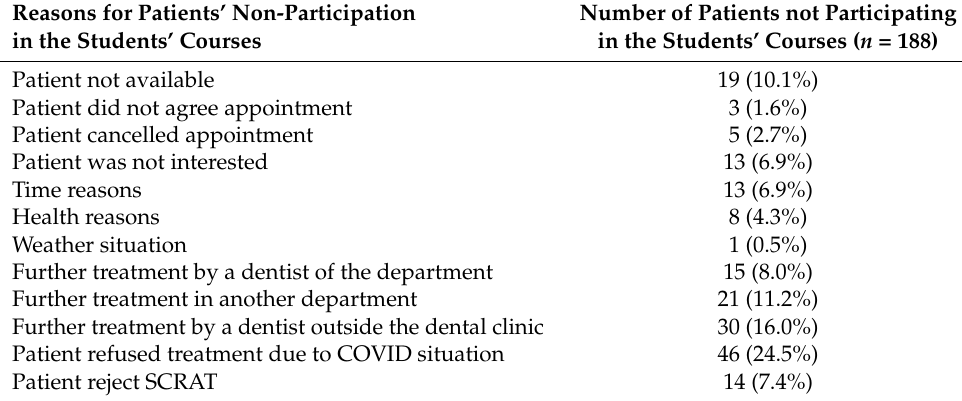
Table 2. Reasons for non-participation of pre-registered patients in the student